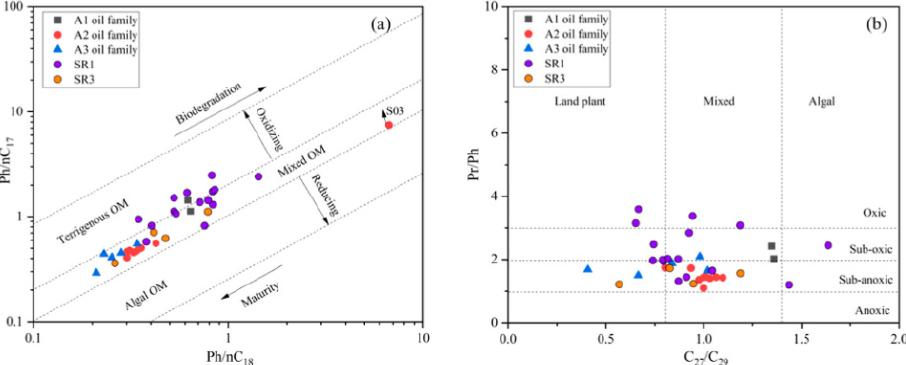
Figure 14. Comparison of geochemical characteristics of oil: ( a ) Ph/ n C 17 plotted against Pr/ n C 18 and ( b ) Pr/Ph plotted against C 27 /C 29 (Adapted with permission from Ref. [51], 2022, X. Ma.)